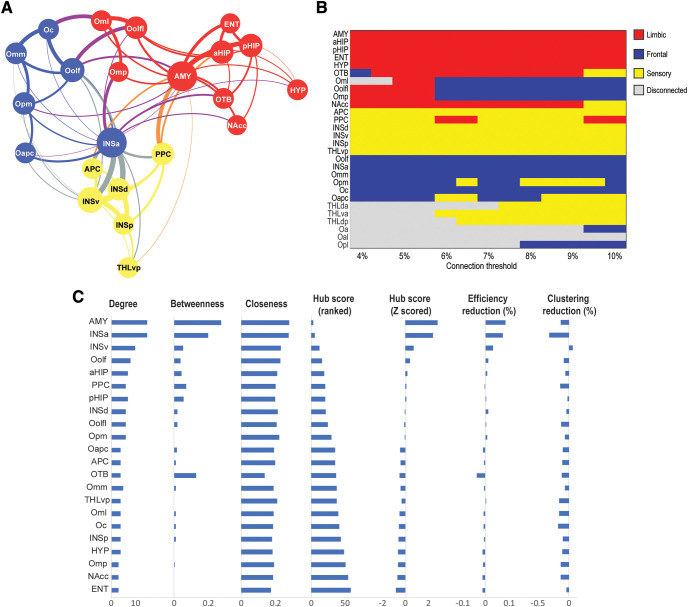
Local network metrics. A, Topology of the olfactory network. The three modules/subnetworks are indicated by the three colors of the circles. Line thickness indicates connection strength (mean correlation coefficients), and node size reflects connection density (number of connections). B, Modularity across a range of connection thresholds. Each row corresponds to one of the 28 ROIs, and columns indicate the connection threshold applied to the network while color indicates the module assignment. In general, nodes were consistently assigned to three modules identified as the limbic (red), sensory (yellow), and frontal (blue) subnetworks. At some connection thresholds, nodes were no longer connected to the network, which is indicated in gray. C, Hubness of a node as reflected by composite hub ranking and composite hub Z-scores. The three centrality indices (node degree, betweenness, and closeness centrality) are also displayed. The AMY and INSa separated from the other nodes as major hubs of the network. Changes in global efficiency of the olfactory network following a node removal were small except for the AMY and INSa nodes, which resulted in 8.5% and 7.3% reductions in global efficiency, respectively.